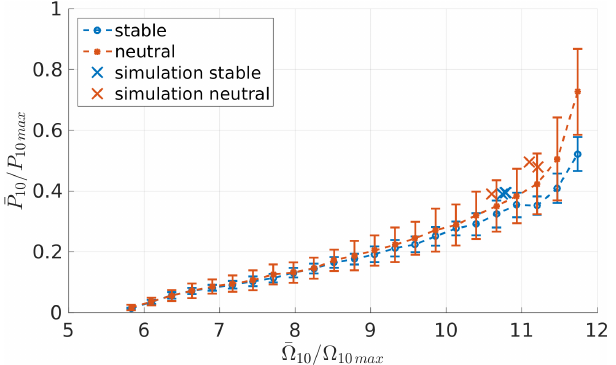
Figure 19. Power output normalised by the maximum measured power, plotted with respect to the rotor speed, and normalised with the maximum measured rotor speed with an added offset for the measurement data in comparison to the simulation data.